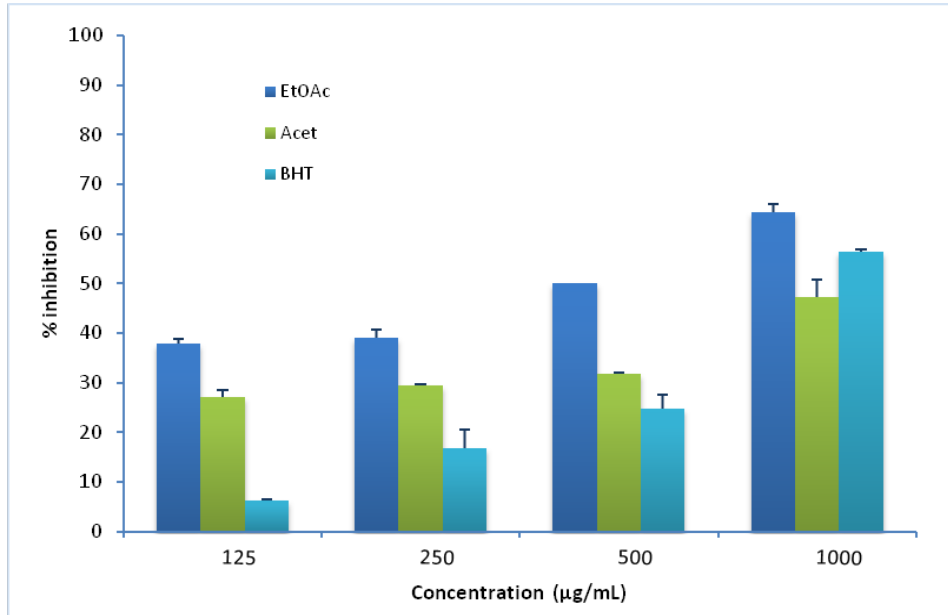
Figure 1. Lipid peroxidation inhibition %/linoleic acid inhibition percentage of the Ethyl acetate (EtOAc) and Acetone (Acet) extracts of Carob seed peels vs.